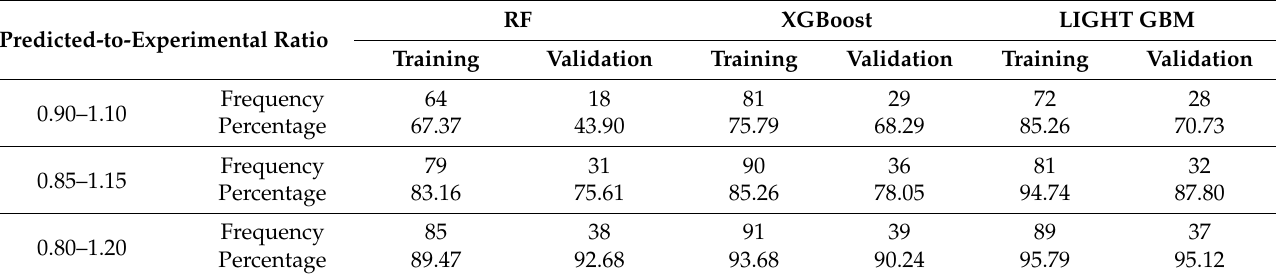
In Figure 6, the dashed radial lines (blue) denote the standard deviation (SD), the dashed straight lines (black) denote the correlation coefficient (CC), and the continuous radial lines (red) indicate the centered root-mean-square deviation (CRMSD) between the training and testing datasets and the experimental dataset. The Taylor diagrams (shown in Figure 6) for the training and testing datasets provide more visualization of the accuracy of all of the proposed models using correlations and errors between the predicted and experimental values. These diagrams statistically summarize the data to assess the